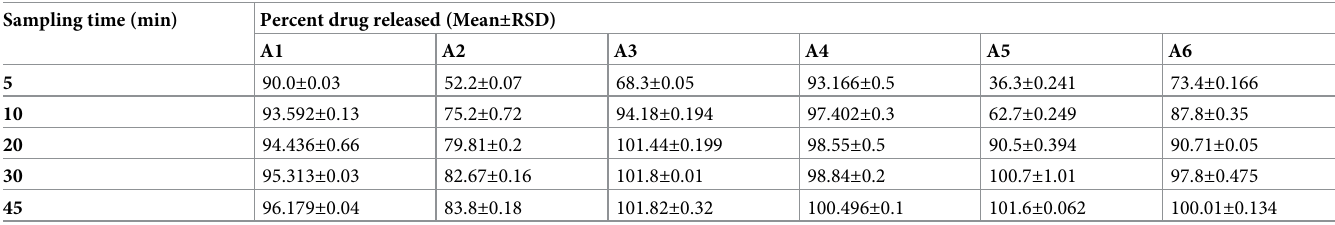
Table 10. Dissolution profile result of azithromycin tablet evaluated in the study. Sampling time